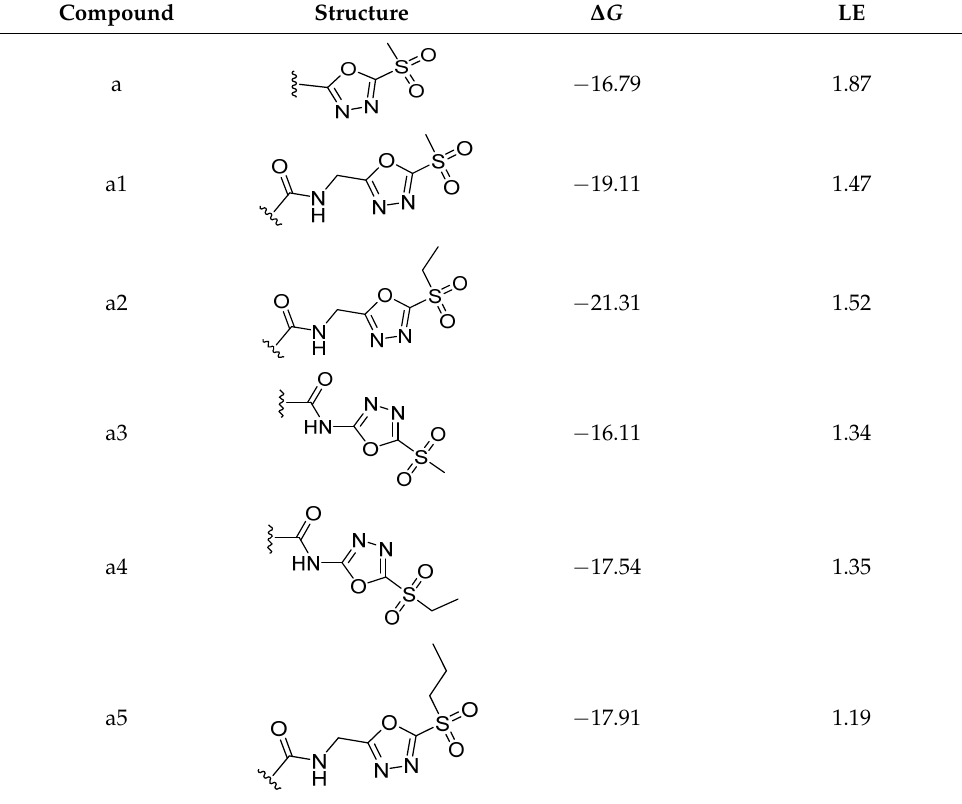
Table 3. The fragment structure generated from core 1 and 2 via ACFIS webserver.